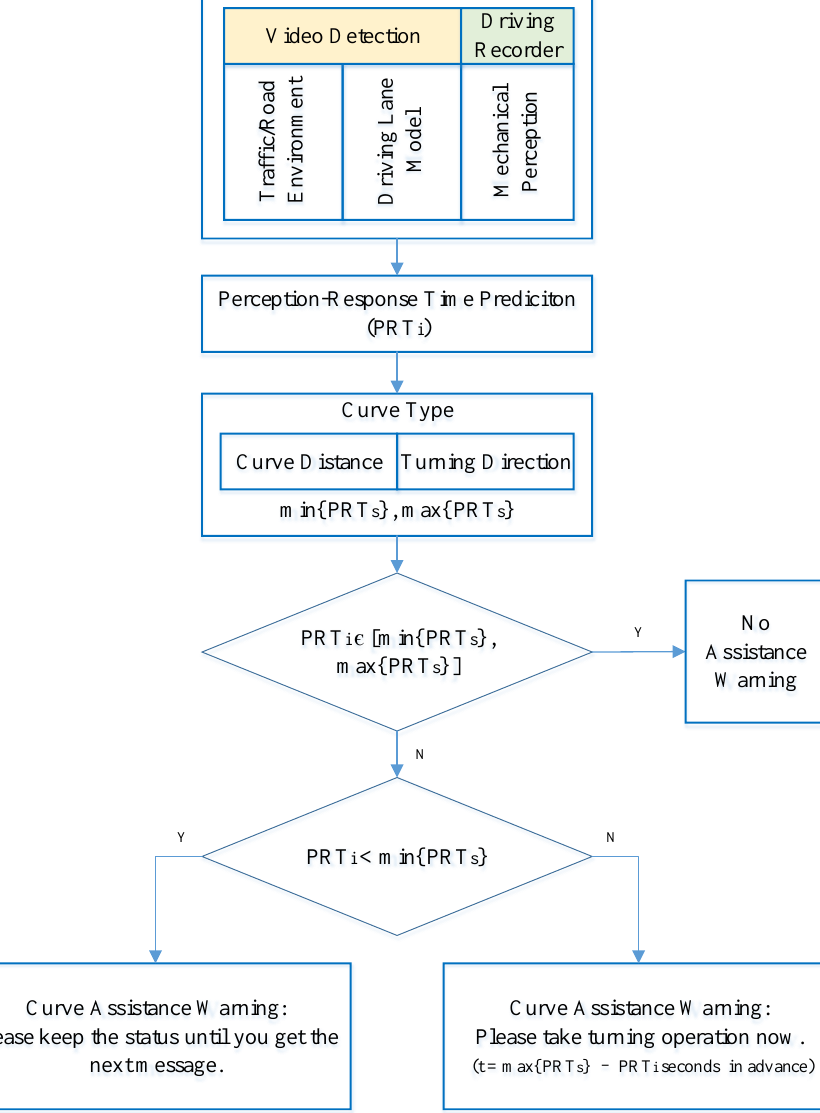
Figure 7. Perception-response time assistance model flowchart.